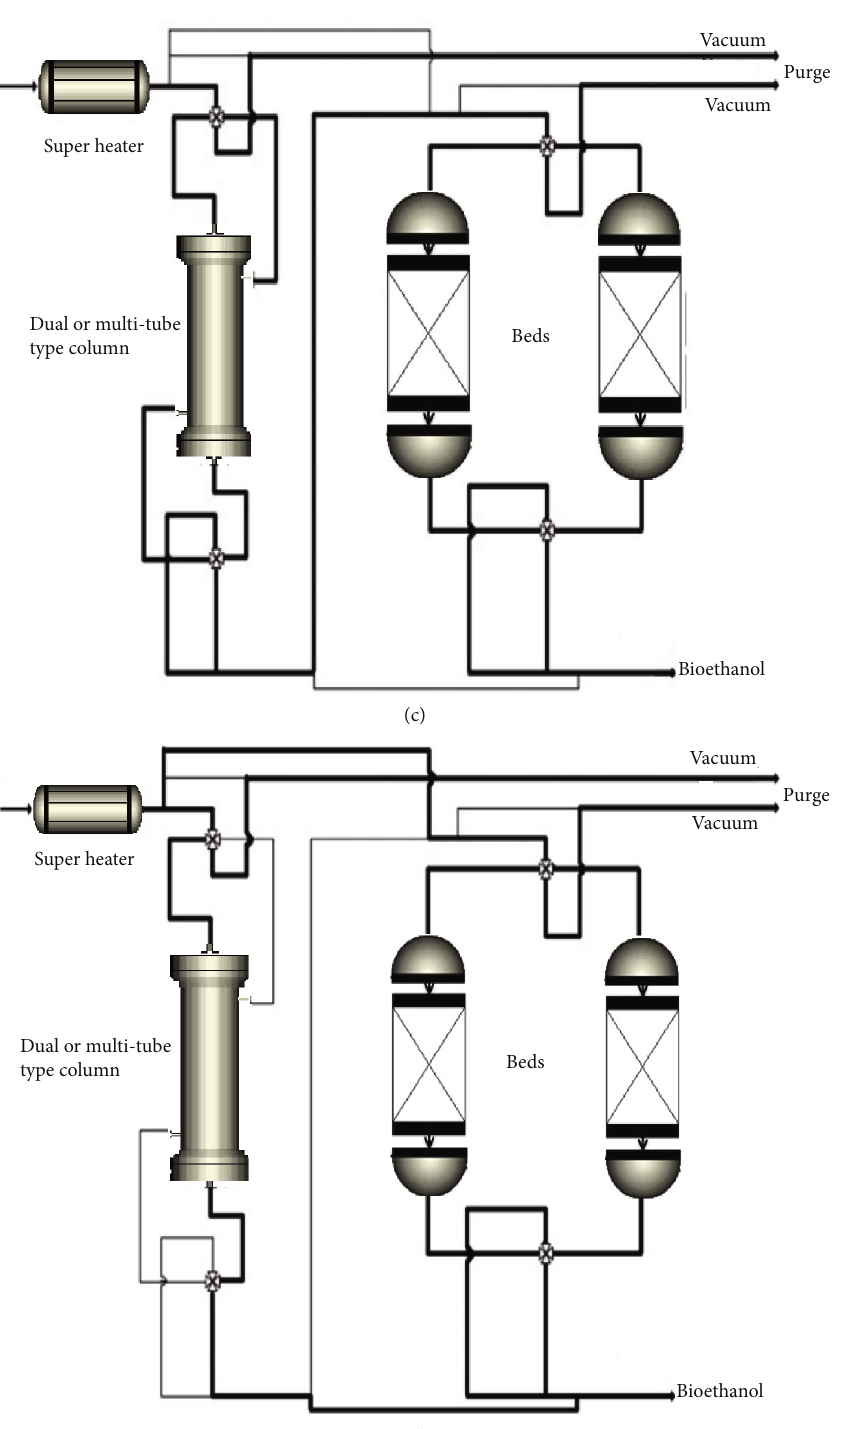
Figure 3: Schematic diagram of the PSA process using di ff erent types of connection con fi gurations: (a) two beds, (b) multiple tubes, (c) two- pass beds, and (d) three